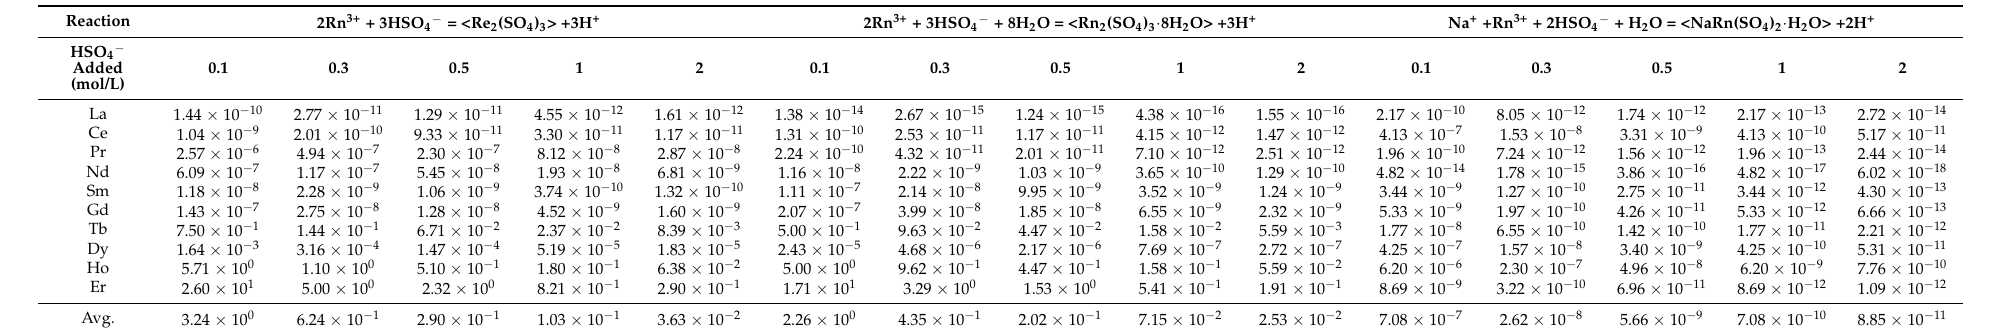
Table 2. Concentrations of Rn 3+ in equilibrium with three sulfate precipitates; anhydrous, octa-hydrated, and sodium double salt at pH 1 with HCl.